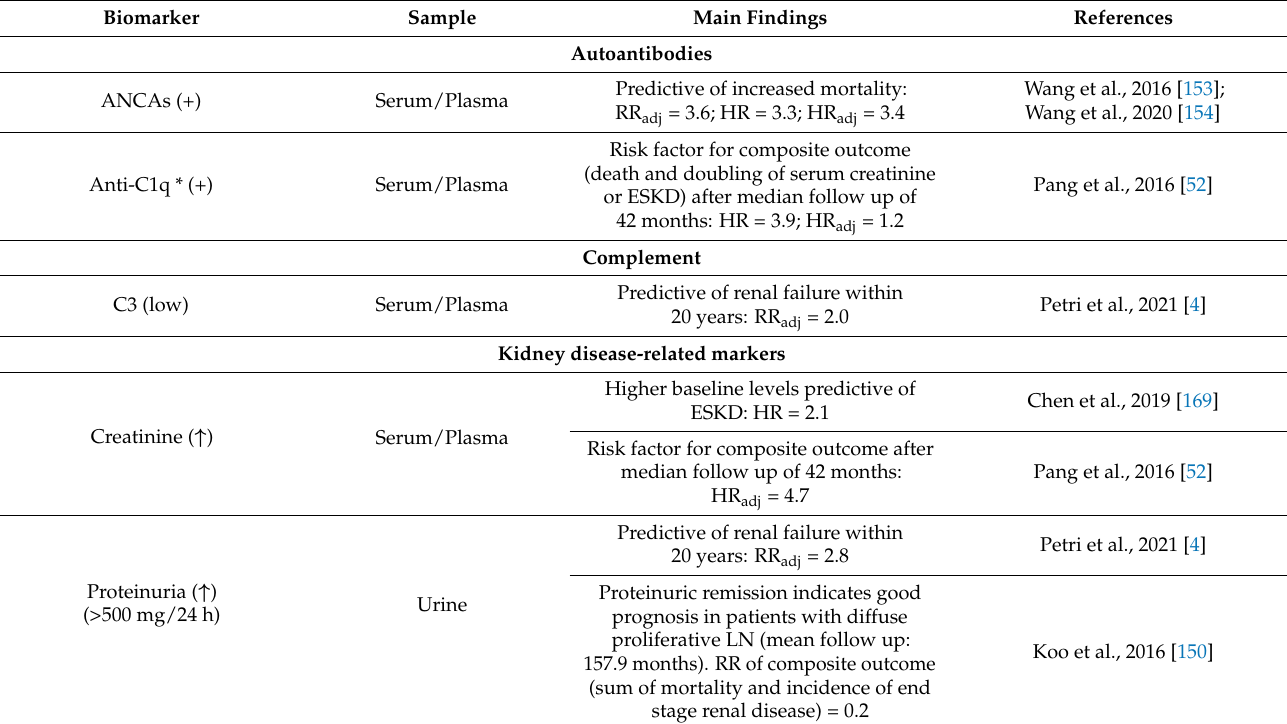
Table 6. Performances of selected prognostic biomarkers in